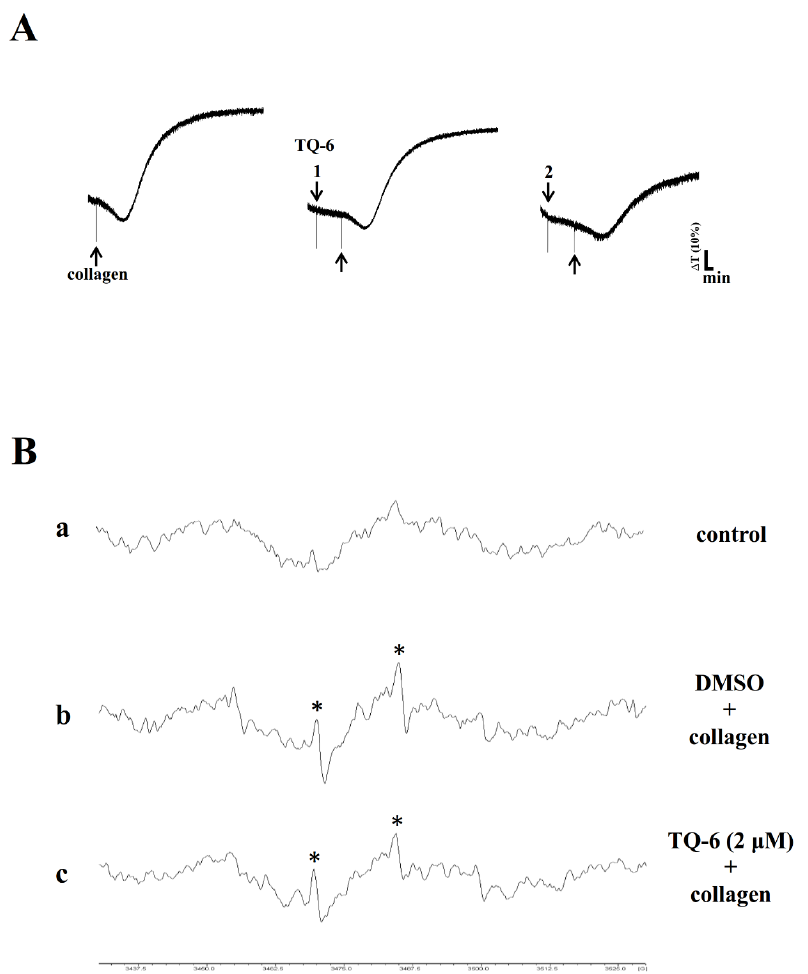
Figure 5. TQ-6-induced suppression of platelet aggregation and OH • formation in collagen-activated mice platelets. ( A ) platelet-rich plasma (PRP) was preincubated with 0.1% DMSO or TQ-6 (1 or 2 μM), and subsequently treated with 2 μg/mL collagen to induce platelet aggregation. ( B ) For the ESR analysis, platelet suspensions were incubated with ( a ) only 0.1% DMSO (control) or preincubated with ( b ) 0.1% DMSO or ( c ) 2 μM TQ-6, and subsequently treated with 2 μg/mL collagen. The profiles of A and B represent four independent experiments, and the asterisk (*) indicates OH • formation.